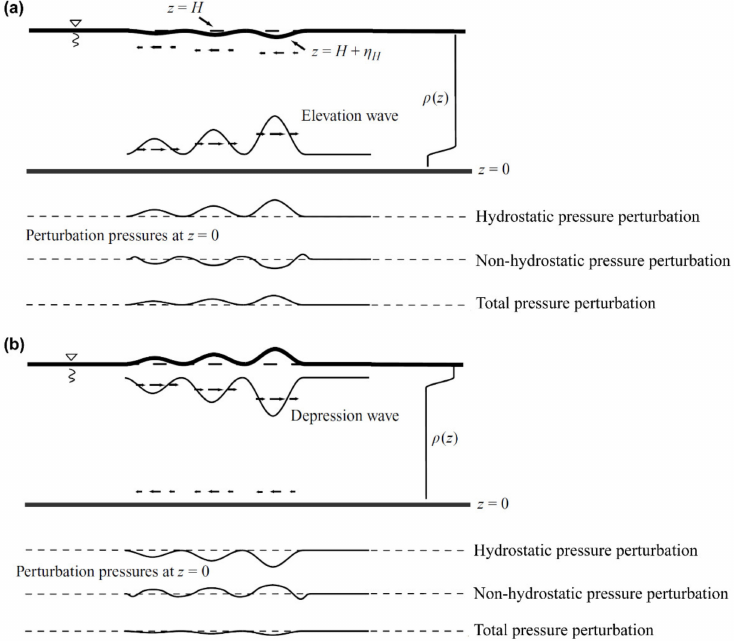
Figure 2. Schematic bottom pressure structure induced by NLIWs. ( a ) Comparable between surface wave displacement, hydrostatic pressure, non-hydrostatic pressure, and total pressure in an NLIW train of elevation propagating to the right. The black arrows show the relative velocity of the wavefronts and induced near-surface velocity. ( b ) A similar structure for NLIW train of depression propagating to the right. Panels ( a , b ) adapted from Moum and Smyth [46], with permission from Cambridge University